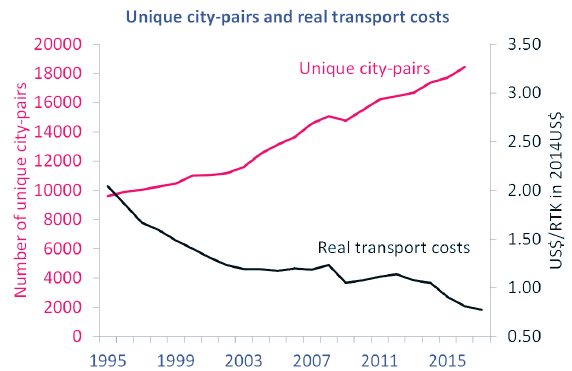
Figure 1. Analysis of costs of air transport and the number of connections between cities of origin and cities of